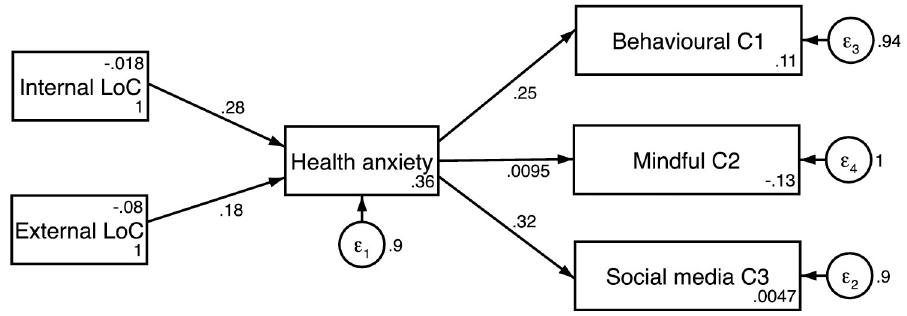
Fig 2. Structural path model for 18–31 years.